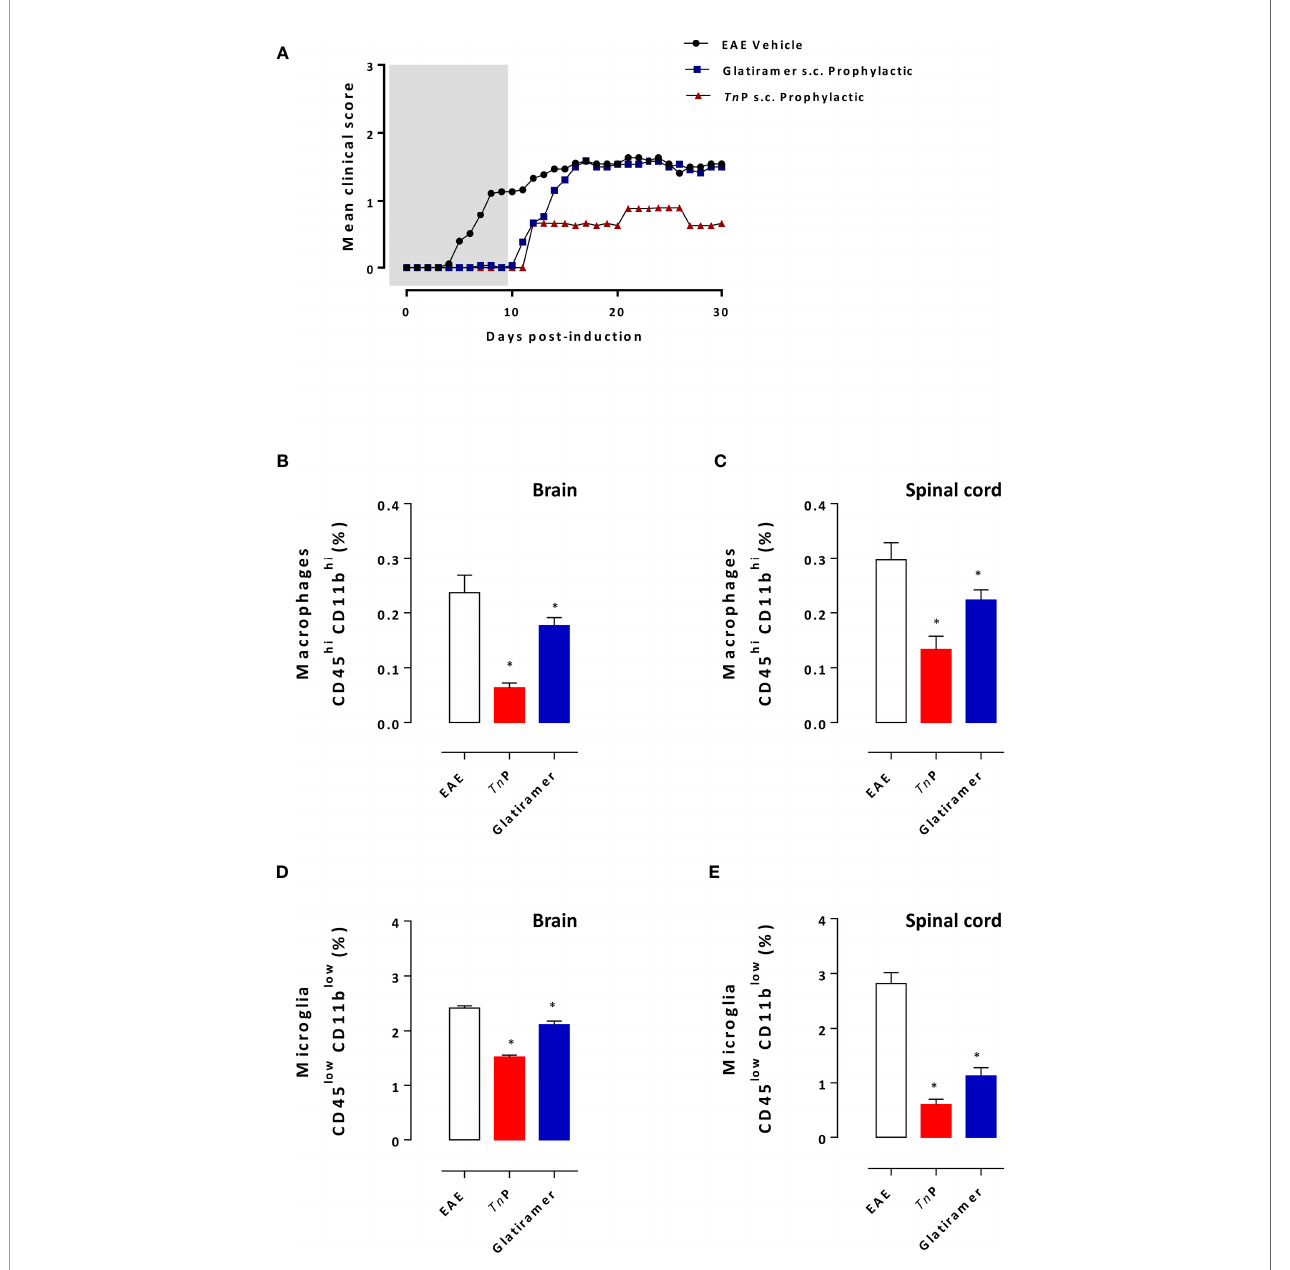
FIGURE 3 | Tn P is more ef fi cient than glatiramer in ameliorating the clinical signs of EAE, in fl ammation and demyelination. BL6 mice (n = 5/group) immunized with (MOG) peptide in incomplete Freund ’ s adjuvant added with M . tuberculosis were injected 2 times with Pertussis toxin after immunization. Mice were scored (0 – 5) daily for 30 d for evidence of clinical disease (A) . Mice were s.c. treated with Tn P at 3 mg/Kg or glatiramer at 2 mg/mice every other day starting at the day 0 of immunization until day 9 (prophylactic regimen). The EAE controls were injected with 0.9% saline alone (Vehicle). At day 17 post immunization, CNS-in fi ltrating leukocytes were isolated from pooled brain (B , D) and spinal cord (C , E) homogenates of all mice and the percentage of microglia (CD45lowCD11blow) and in fi ltrating macrophages (CD45 high CD11bhigh) were analyzed by fl ow cytometry after acquisition of 100,000 events as shown in the schematic image of Supplementary Figure 1A . Values in the bar graphs are the mean ± SEM. * p < 0.05 compared with vehicle-treated EAE